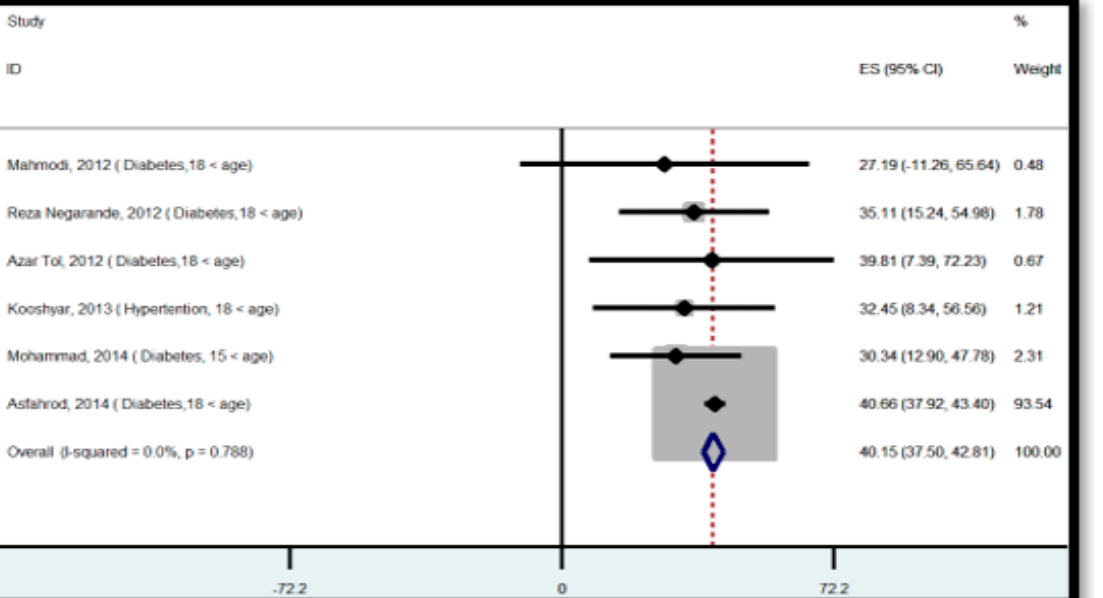
Figure 4. Forest plot of health literacy status in patient population after 2014, stratified by type of instruments, ES: effect size, I 2 : a measure of the ratio of the total variation in study measures due to heterogeneity, p > 0.05: devastates heteroge- neity is appropriate for interpretation.